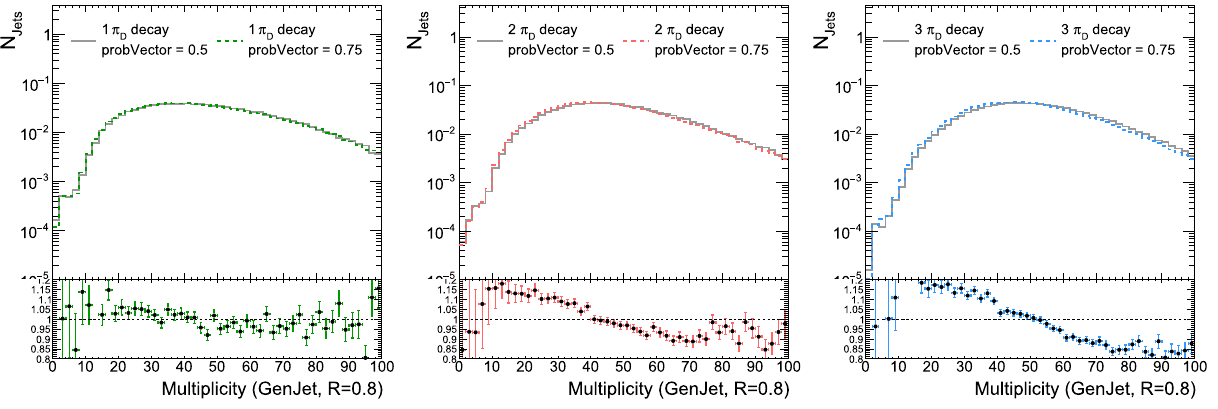
Fig. 43 Comparison of number of constituents in jets between probVector=0.5 (grey solid line) and probVector=0.75 (colored dashed line). The comparison is made for 1 (left), 2 (middle) and 3 (right) dark pions decay. The plotted ratio is the ratio of probVector=0.75 to